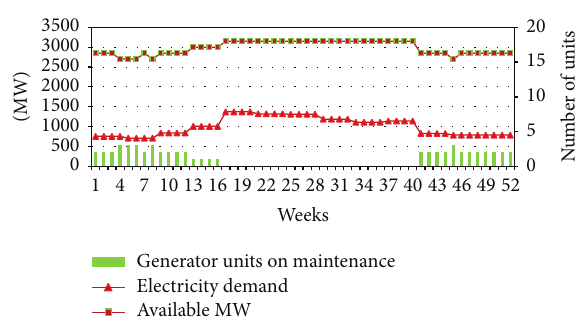
Figure 12: Unit system output loads and gross reserves for 21